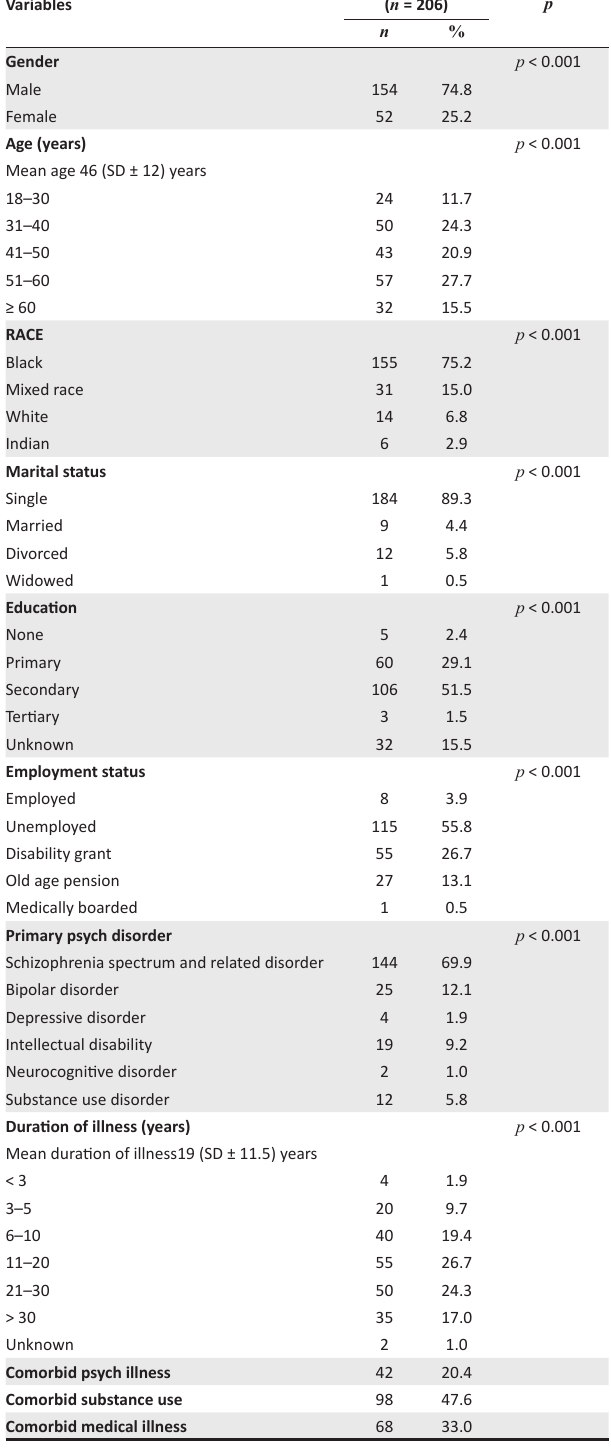
TABLE 1: Sociodemographic and clinical characteristics of the study population .